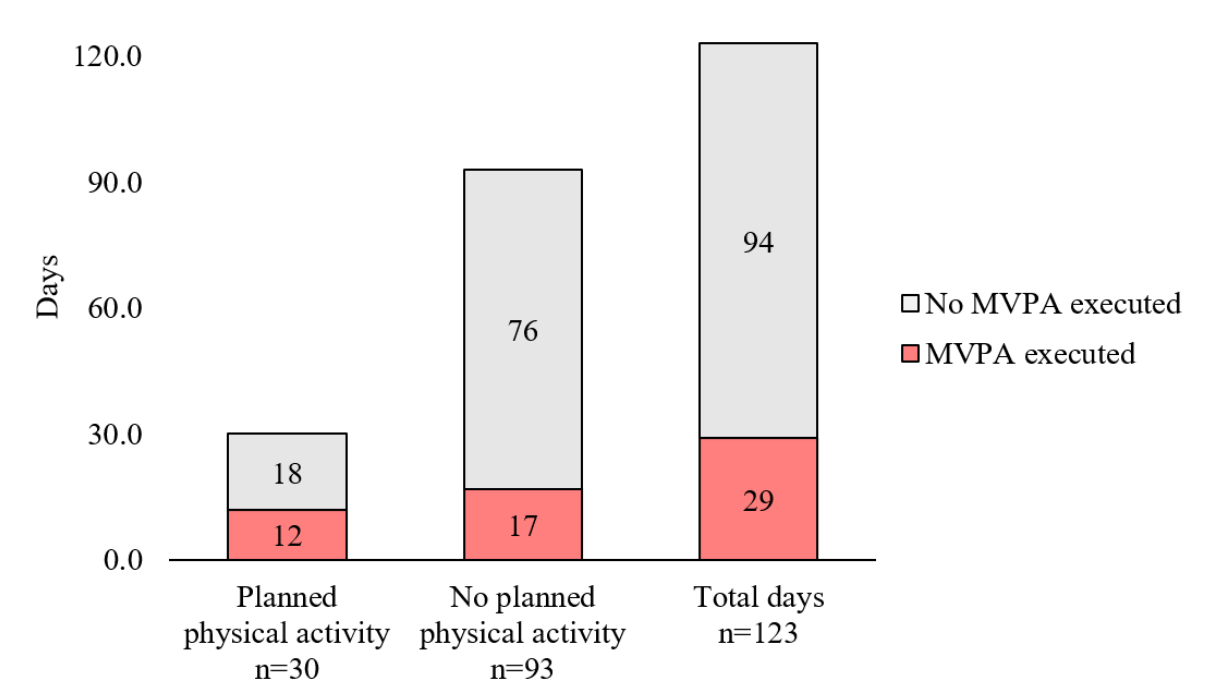
Figure 2. Planned versus performed physical activity. MVPA: moderate-to-vigorous physical